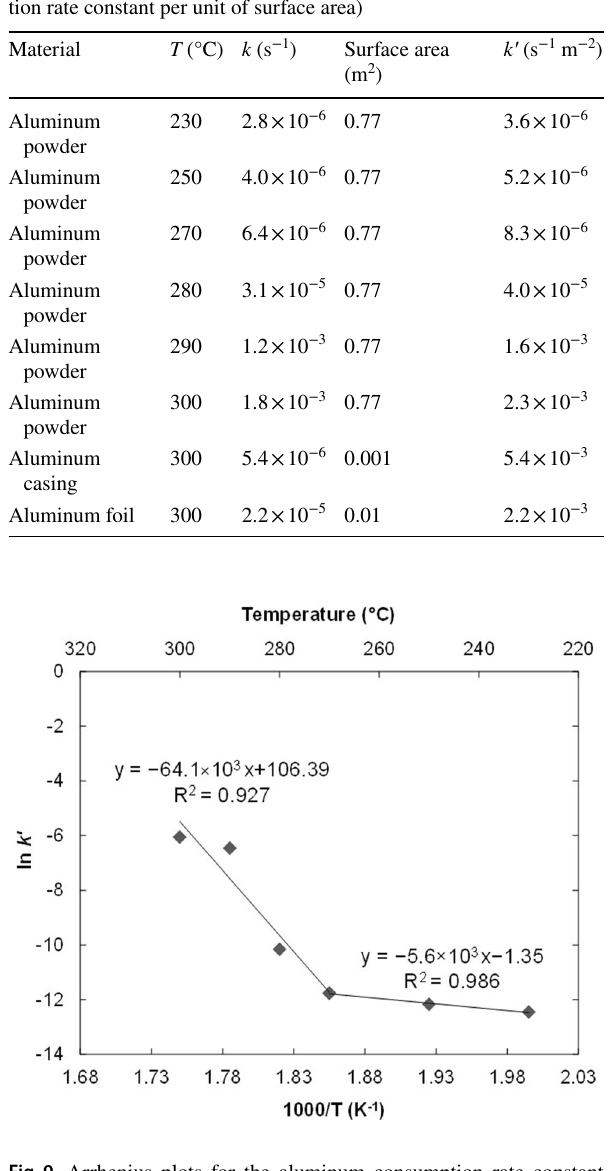
Fig. 9 Arrhenius plots for the aluminum consumption rate constant per unit of surface area ( k ′ ) between 230 and 300 °C